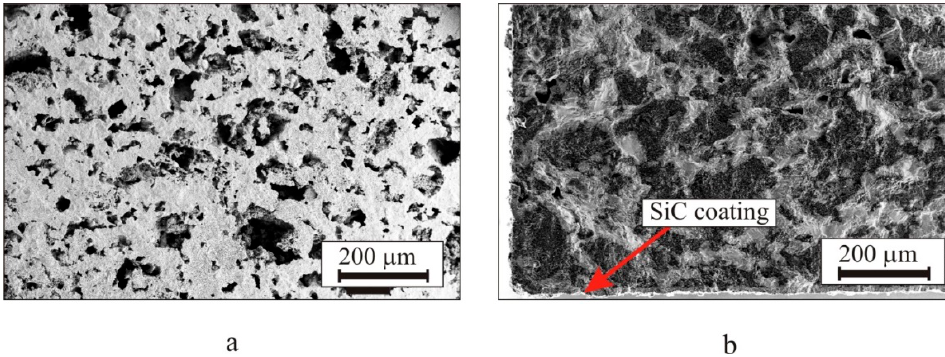
Figure 10. Microstructure of composite material SiC-C-Si/50-40-10 without a coating ( a ) and with a gas-tight SiC coating ( b ) after annealing at 1000 ◦ C in air for 60 h. Table 2. Weight of samples from SiC-C-Si/50-40-10 ceramics without a coating and with a protective SiC coating before and after annealing.